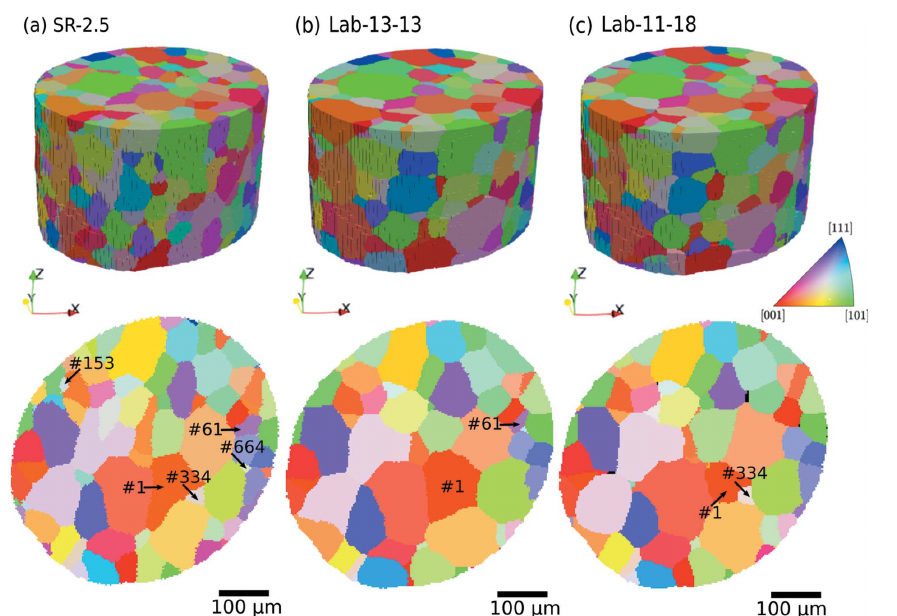
Figure 1 Grain structure datasets visualized in 3D in the top row and slices normal to the Z axis (sampled at a distance of 115 m m from the top surface) in the bottom row. ( a ) SR-2.5, ( b ) Lab-13-13 and ( c ) Lab-11-18 datasets. Some grains of interests are marked by numbers in the slices.